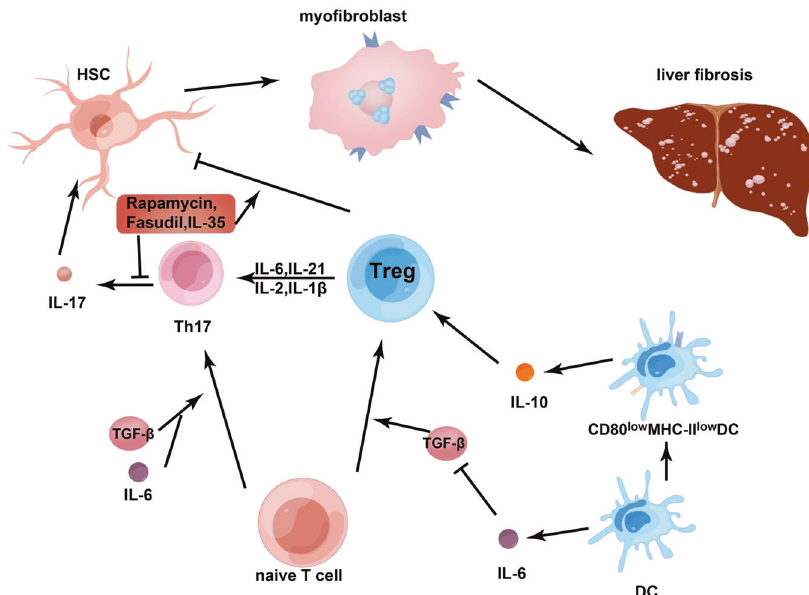
Fig. 3 The relationship between Tregs and Th17. Treg and Th17 cells are convertible in different immune microenvironments. Treg cells can be transformed into cells expressing IL-17 in the presence of IL-6 and IL-21, as well as IL-2 and IL-1 β . Fasudil can effectively inhibit cell differentiation of Th17 and its ability to express IL-17. Using this inhibitor and upregulation of Treg can limit liver fi brosis in mice caused by Schistosoma japonicum infection. Rapamycin signi fi cantly reduced the level of Th17 cells in the CCL4-induced liver fi brosis model, it even can enhance the inhibitory function of Treg on HSCs.IL-35 has a similar function compared with the formers. Il-6 has an extraordinary effect on Th17/Treg balance. Il-6 can induce the development of naïve T cells into Th17 cells in the existence of TGF- β . However, its effect on Tregs has two sides. But overall, IL-6 still tilts the balance between Tregs and Th17 toward Th17 cells. DCs play dual roles in the pathways of Treg. Footnote: regulatory cells (Treg), T helper cell (Th), interleukin (IL), retinoid-related orphan receptor gamma t (ROR γ t), carbon tetrachloride (CCL4), hepatic stellate cells (HSCs), dendritic cells